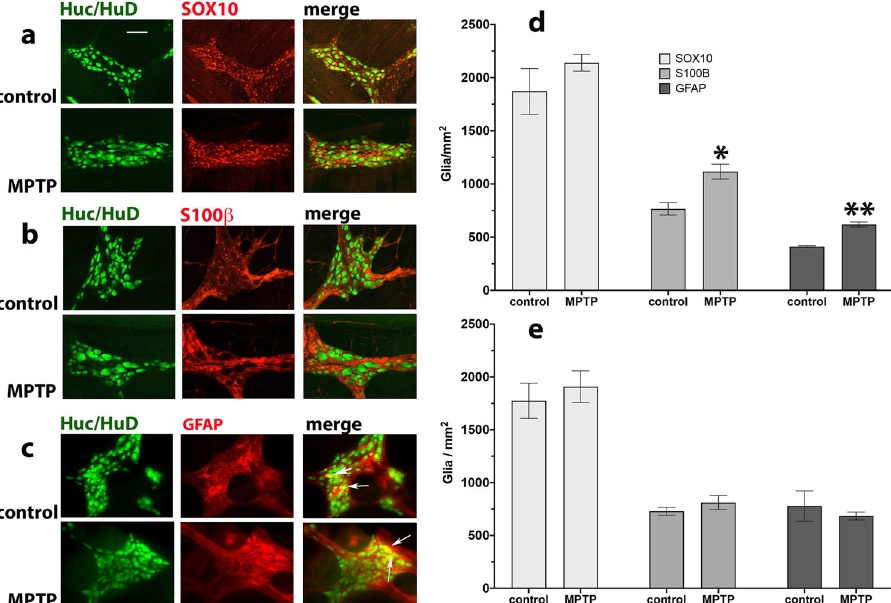
Fig. 9 Effect of MPTP treatment on SOX-10-, S100 β - and GFAP-ir glial cells in the myenteric plexus of the proximal colon of naïve control and MPTP-treated common marmosets. Panel ( a ) shows SOX-10-ir, ( b ) S100 β -ir and ( c ) GFAP-ir. With the exception of GFAP-ir ( c ) there was no signal overlap between the immunoreactivity of glial and neuronal cells. The white arrows indicate colocalisation of GFAP-ir and Huc/HuD-ir cells. The arrows indicate glial/neuronal overlap. Quantitative analysis of glial cells in MPTP-treated marmosets compared to na ϊ ve controls in the proximal and distal colon is shown in panels ( d ) and ( e ), respectively. The number of immunoreactive neurons are expressed as mean ± SEM. Scale bar in panel ( a ) indicates 100 µm. * P = 0.02; ** P = 0.0016 two-way ANOVA, Sidak multiple comparison